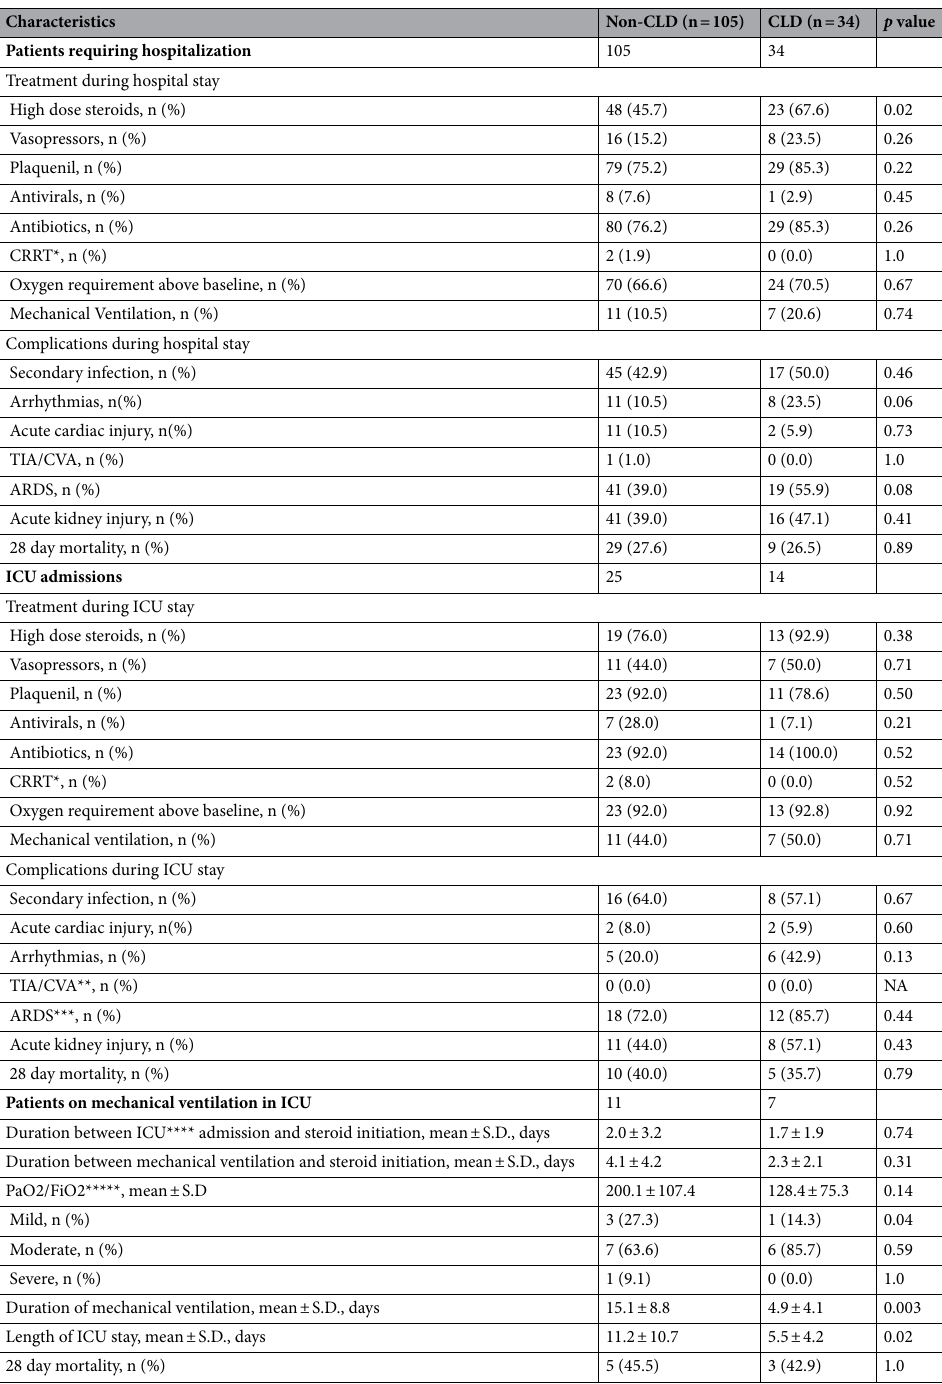
Table 3. Hospitalization and critical care outcomes of admitted COVID-19 patients with or without chronic liver disease (CLD). CRRT*, continuous renal replacement therapy; TIA/CVA**, transient ischemic attack/ cerebrovascular accident; ARDS***, acute respiratory distress syndrome; ICU****, intensive care unit; PaO2/ FiO2*****, ratio of arterial oxygen partial pressure (PaO2) to fractional inspired oxygen